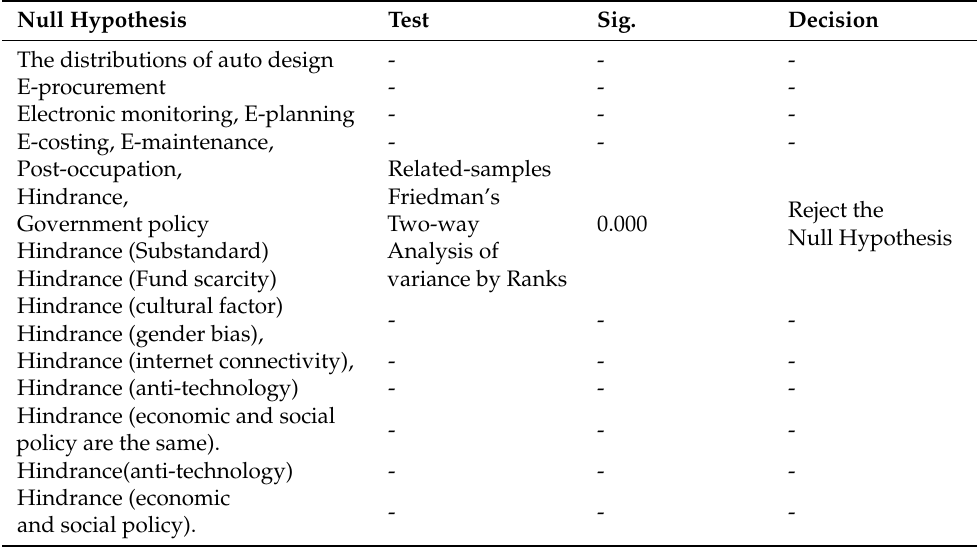
Table 7. Summary of Hypothesis Test on Effectiveness of Distribution of Drivers that are important to I4.0 and